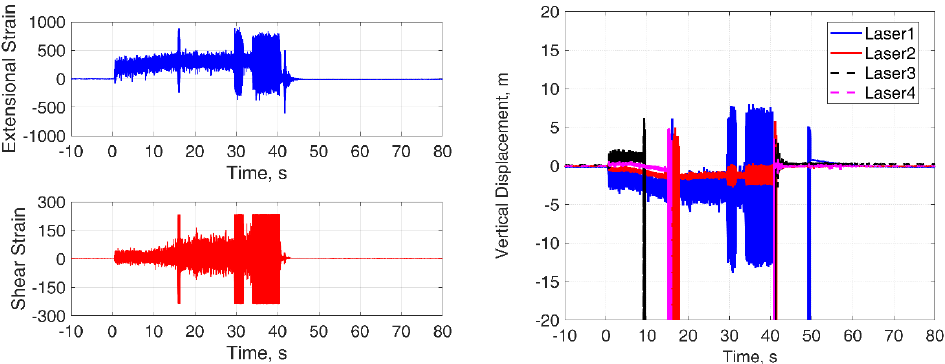
Figure 14. Outputs of the strain gages and the laser displacement sensors.